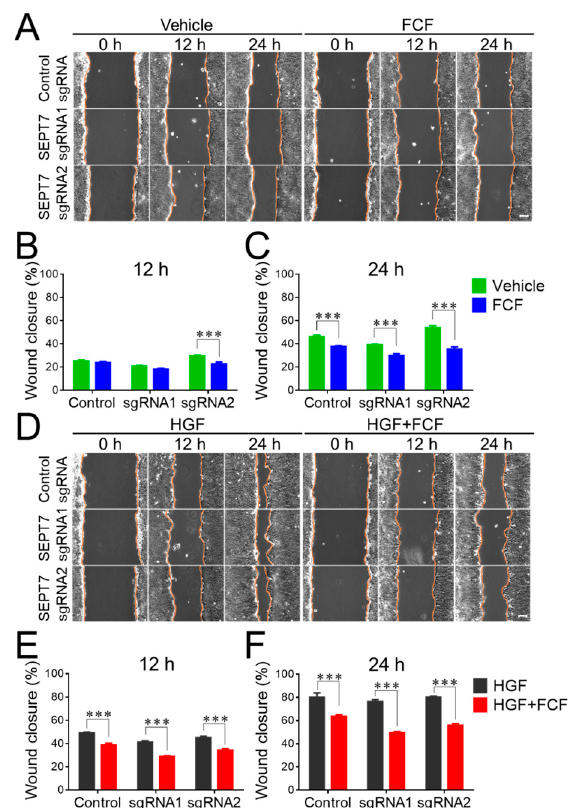
Figure 4. Forchlorfenuron inhibits spontaneous and hepatocyte growth factor-induced migration of control and septin-deficient colonic epithelial cells. HT-29 cells with stable CRISPR/Cas9 mediated knockout of SEPT7 and control cell monolayers were subjected to either spontaneous or HGF-induced wound healing assay with, and without, FCF, as described in the Figure 1 legend. ( A , D ) Representative images of wounded HT-29 cell monolayers. ( B , C , E , F ) Quantitation of wound closure during 12 and 24 h of cell migration. Data are presented as a mean ± SE (n = 5); *** p < 0.001. Scale bars, 100 µm.